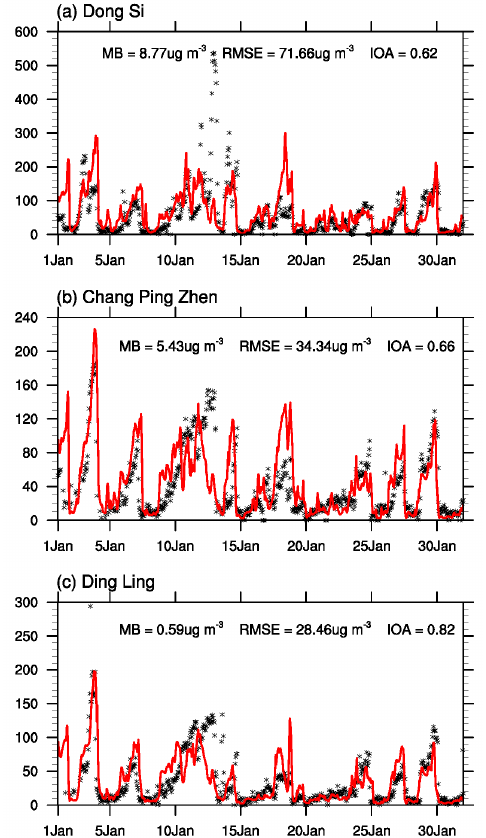
Figure 5. The simulated (red curve) and observed (black curve) temporal evolution of PM 2.5 concen- trations (units: µ g/m 3 ) over ( a ) urban, ( b ) suburban, and ( c ) rural stations.